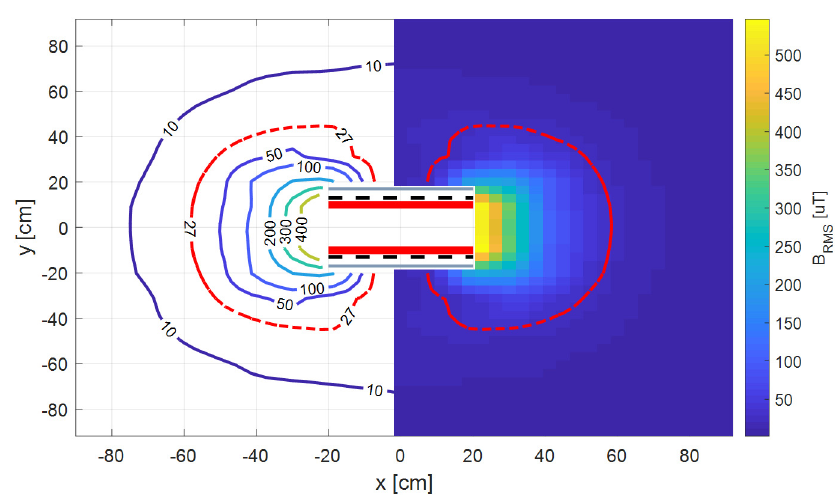
Figure 16. Leakage magnetic field (RMS values) at 20 cm and 4.5 kW .